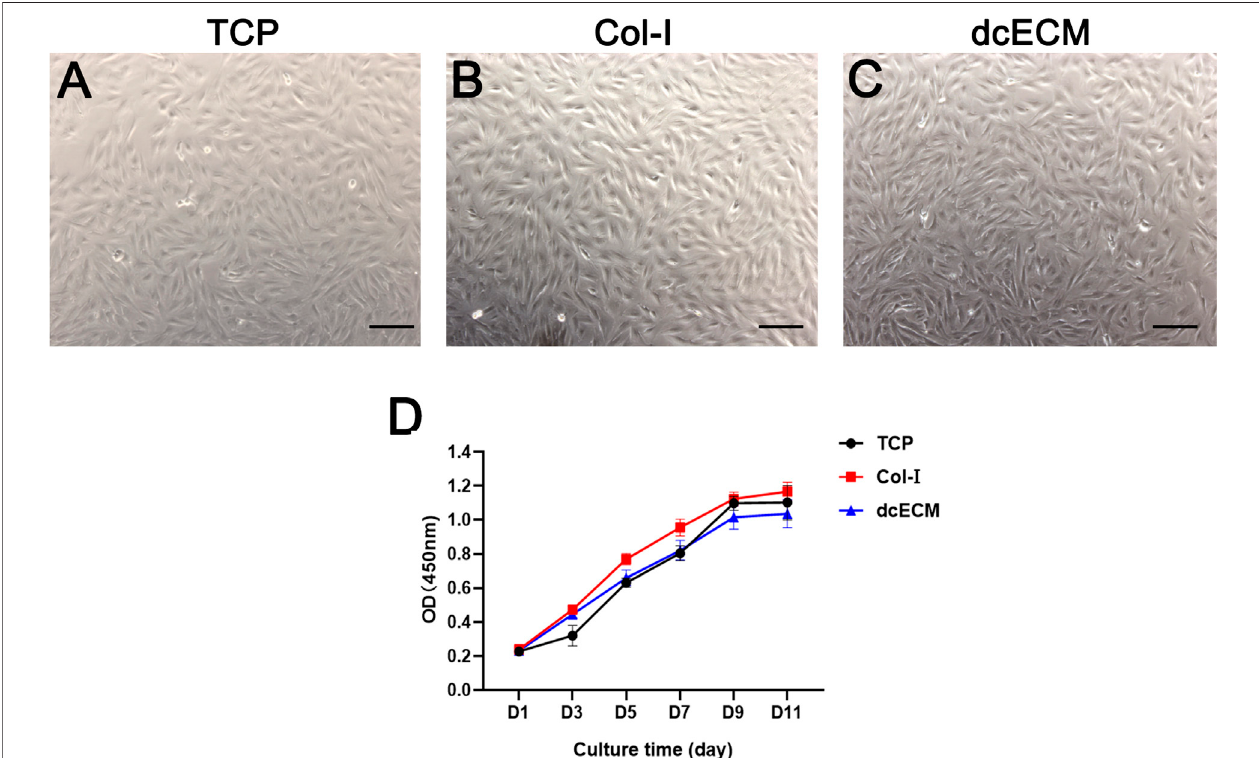
FIGURE 4 | Viability of chondrocytes on TCP, collagen I, and dcECM hydrogels. (A-C) Viability of chondrocytes cultured on TCP (A) , collagen I (Col-I) (B) , and 10 mg/mldcECMhydrogels (dcECM) (C) -coatedplates onday7 (D) Theproliferationcapability ofchondrocytes onTCP,Col-I,and dcECMat1,3,5,7,9,and11 days after cell seeding was assessed using CCK-8 kit. Error bars showed means ± SD, n (cid:2) 6. Scale bars (cid:2) 100